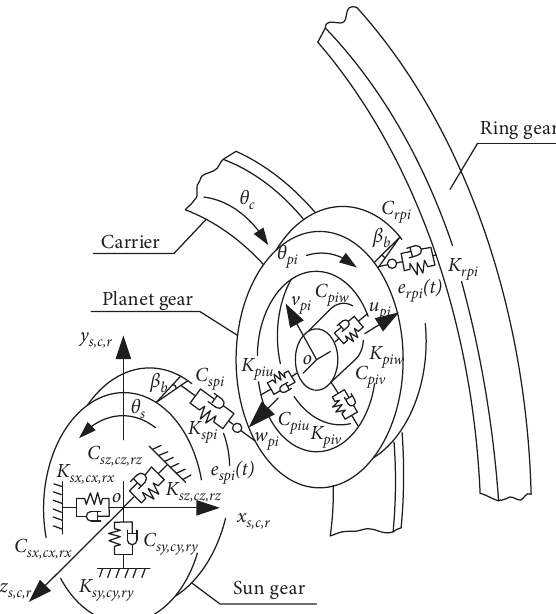
Figure 4: Dynamic model of slice type